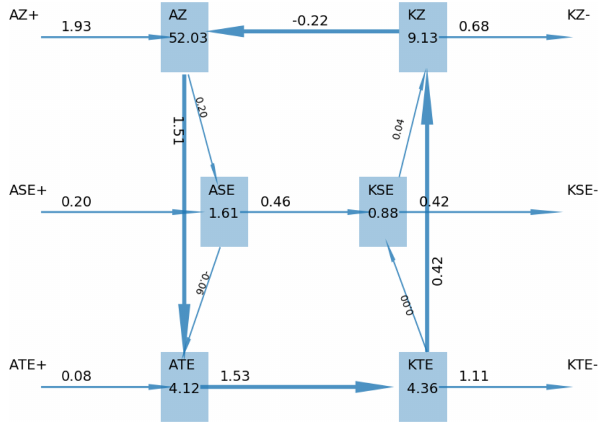
Figure 11. A Lorenz energy cycle flux diagram for 1 year of a CMIP5 model pre-industrial control run (cf. Ulbrich and Speth, 1991). “A” stands for available potential energy (APE), “K” for kinetic energy (KE), “Z” for zonal 1115 mean, “S” for stationary eddies, and “T” for transient eddies. The “ + ” sign indicates source of energy, “ − ” a sink. For the energy reservoirs, the unit of measure is joules per square metre; for the energy conversion terms, the unit of measure is watts per square metre. Similar to Fig. 5 of Lembo et al. (2019) and produced with recipe_thermodyn_diagtool.yml ; see details in Sect. 3.2.4.